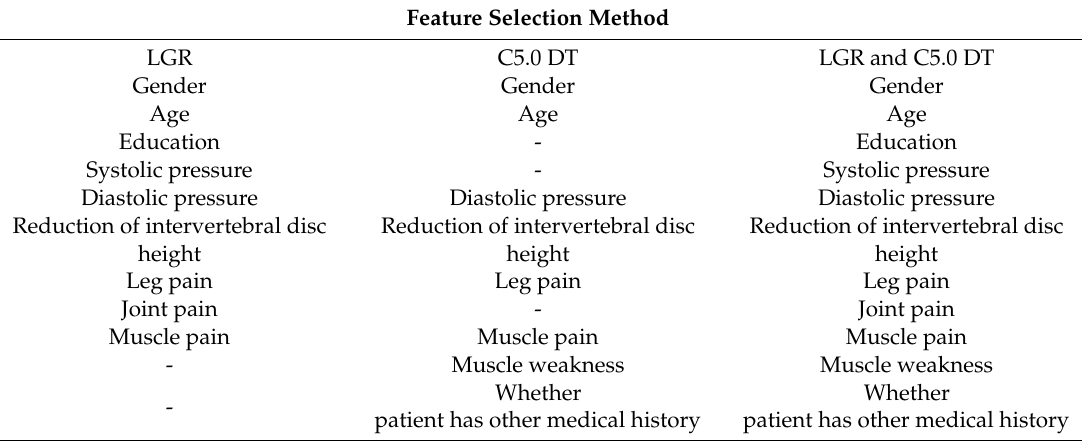
Table 3. Compilation table of the three feature extraction methods.